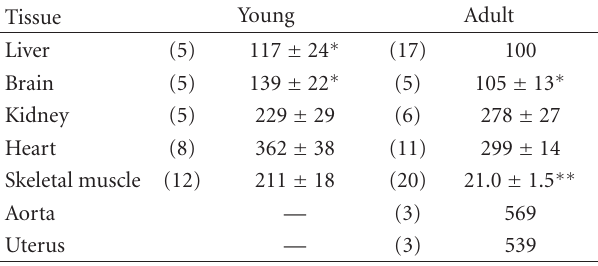
Table 2: Content of full-length utrophin in tissues from young (2– 8 days of age) and adult (6–8 weeks old) rats. Averages of den- sitometric evaluation of immunoblots (SEM is given for averages from 5 experiments or more; number n of experiments in brackets). Values of adult liver are set at 100. For comparison, averages of 3 experiments are given for aorta and uterus. Relative band intensities are always determined in runs together with adult liver and/or heart for calibration. For experimental details, see the Methods section.